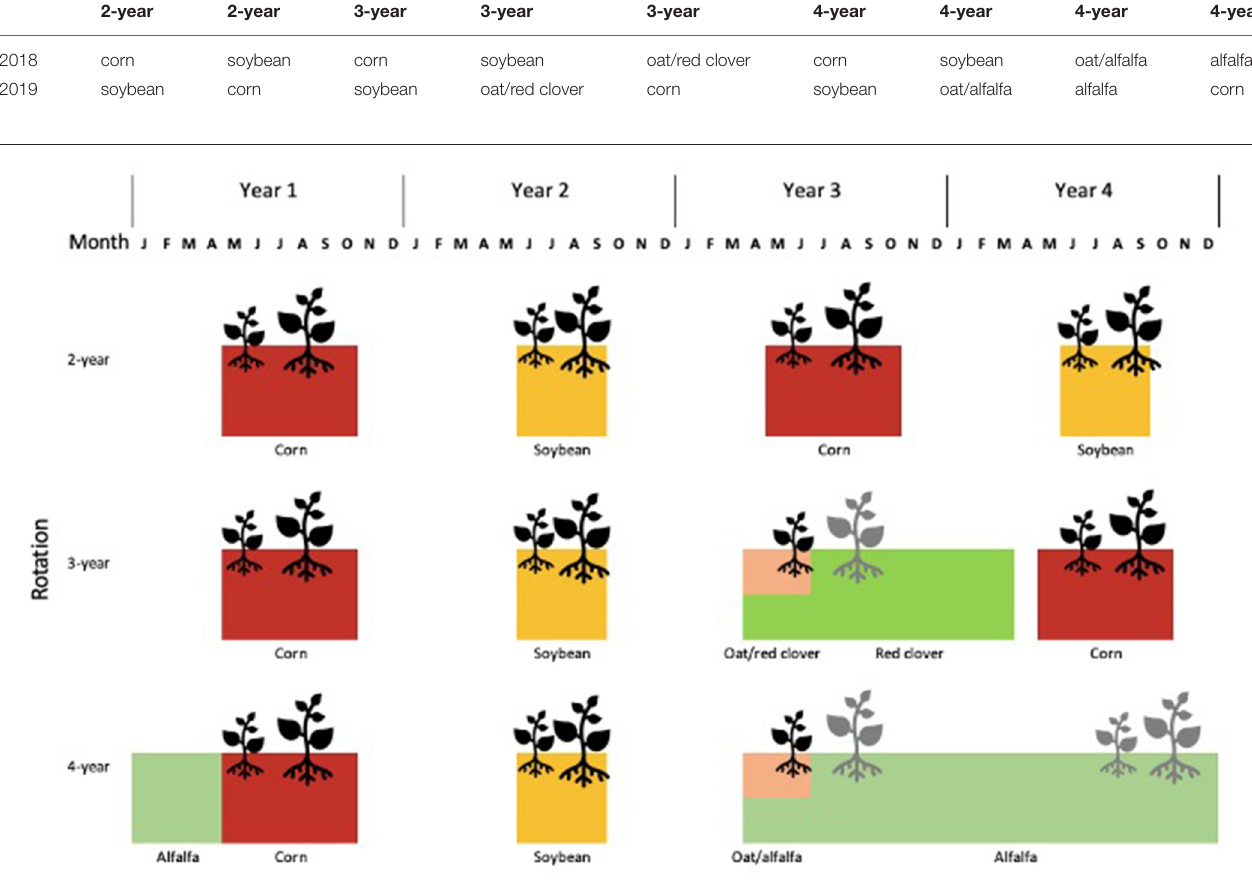
FIGURE 1 | Conceptual diagram of the three rotation systems compared within the experiment. A cycle of four calendar years is shown. Crops are color-coded and displayed for the approximate months that they were present. Emergence and establishment of common waterhemp plants are illustrated with black symbols. Grey plants shown in oat intercropped with red clover or alfalfa’s first year were physically controlled by crop harvest operations. Red clover was not harvested but kept as a living cover crop until senescence. Grey plants shown in alfalfa’s second year were physically suppressed three to four times by hay harvest. Alfalfa’s hay was harvested when approximately 5% of the plants